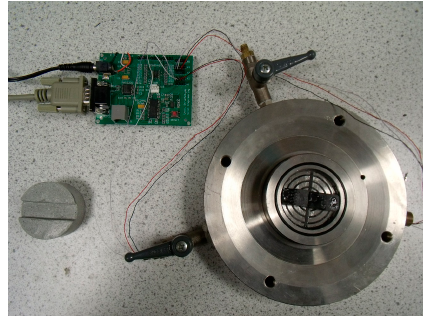
Figure 4. Placement of the relative humidity (RH) sensors in the oedometer and the groove at the bottom of the bentonite.